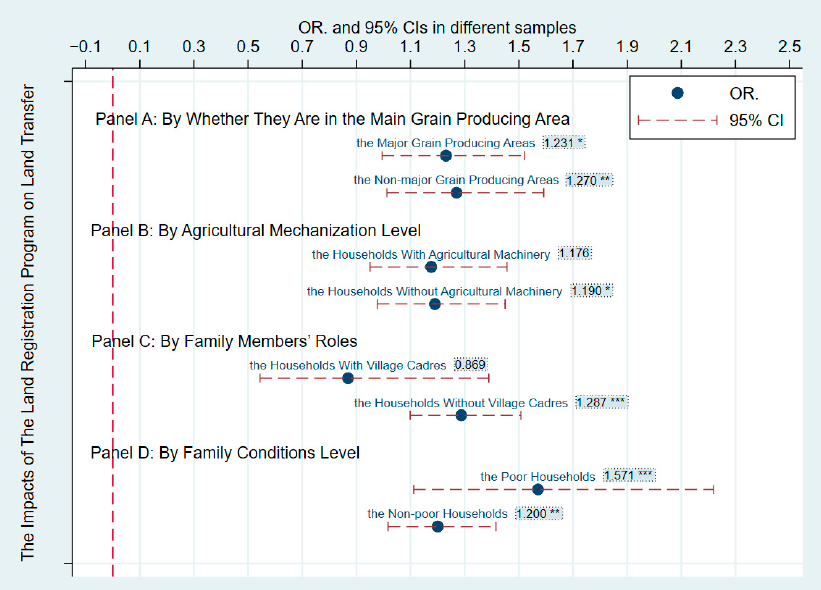
Figure 7. The impacts of the land registration program on land transfer by whether they are in the main grain producing area, agricultural mechanization level, family members’ roles and family conditions level. The panel divides the whole sample into four sub ‐ samples. Each point and the corresponding 90 percent confidence interval are based on a Logit model of Equation (3). The plotted points show the impacts of the land registration program on land transfer among the individuals in the corresponding sub ‐ sample (* p < 0.1, ** p < 0.05, *** p < 0.01). The main grain ‐ producing areas in China are mainly in three major regions: the main grain ‐ producing areas in Northeast China (Liaoning, Jilin, and Heilongjiang); the main grain ‐ producing areas in Huanghuaihai (Hebei, Shandong and Henan); and the main grain ‐ producing areas in the middle and lower reaches of the Yangtze River (Jiangsu, Anhui, Jiangxi, Hunan, Hubei, and Sichuan). First, in terms of whether they are in the main grain producing area, this article divides the whole sample into the major grain producing areas and the non ‐ major grain producing areas. The results in Panel A of Figure 7 indicate that at the 5% level of significance, only land registration in non ‐ major grain producing areas can significantly promote the land transfer of farmers. More specifically, their chances of land transfer after land registration have increased by 27.0%.